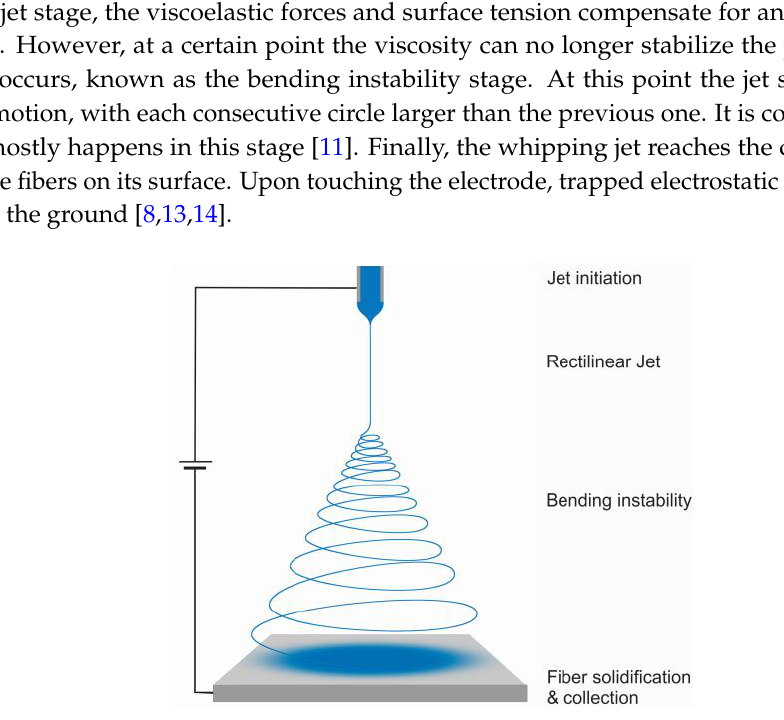
Figure 1. Schematic representation of the electrospinning process.